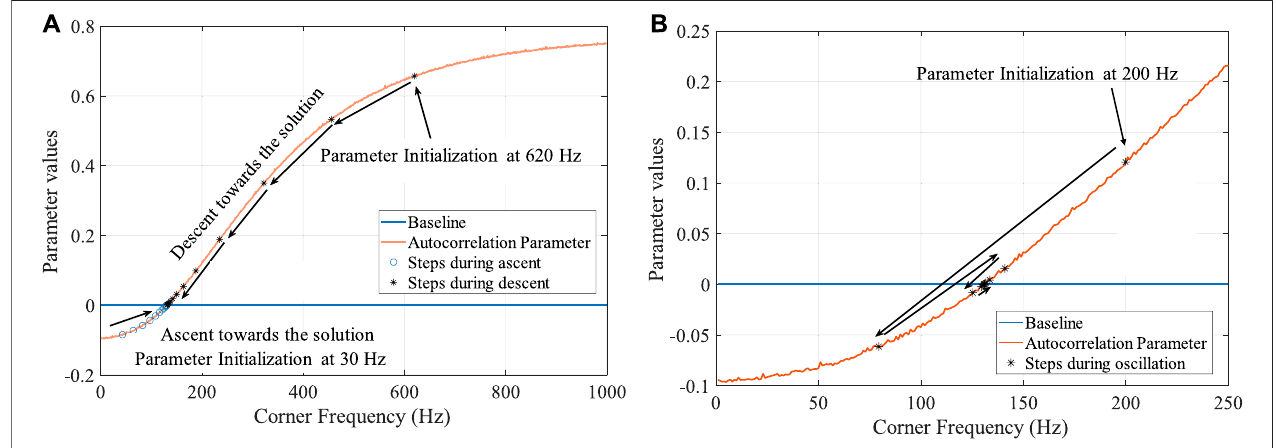
FIGURE 6 | The convergence of the parameter value, corner frequency, is shown for two different learning rates, for the case where laser power is 54 mW. After initializationatthetrailvaluetheparameter stepstowardthezerooftheparameter valueinsmallsteps.Figure (A) showsthecasewherelearningrateissmall,andFigure (B) shows where for a larger learning rate the solution oscillates and moves toward the